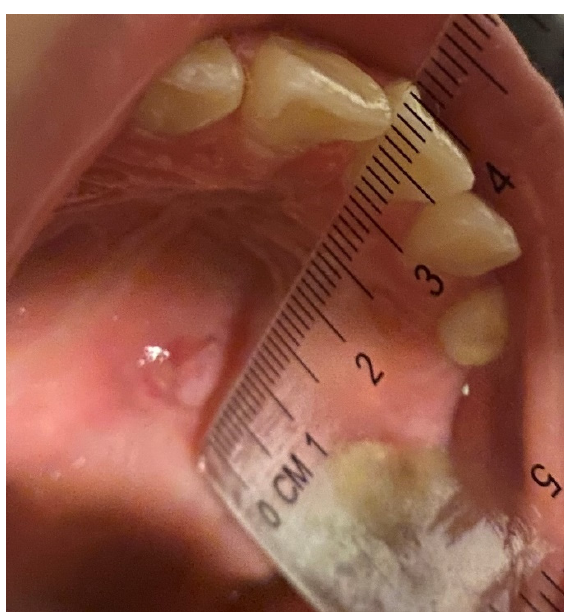
Figure 3. Photo Post gel Test.